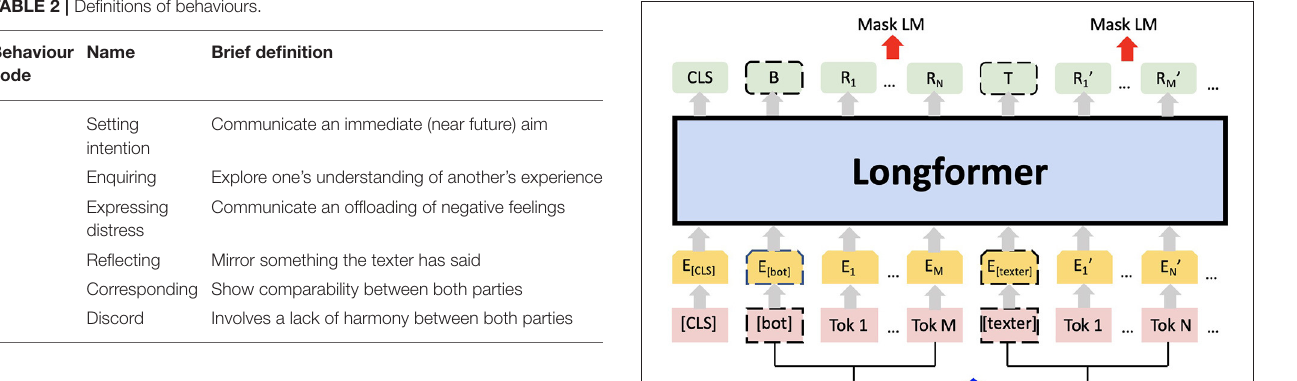
TABLE 2 | Definitions of behaviours.